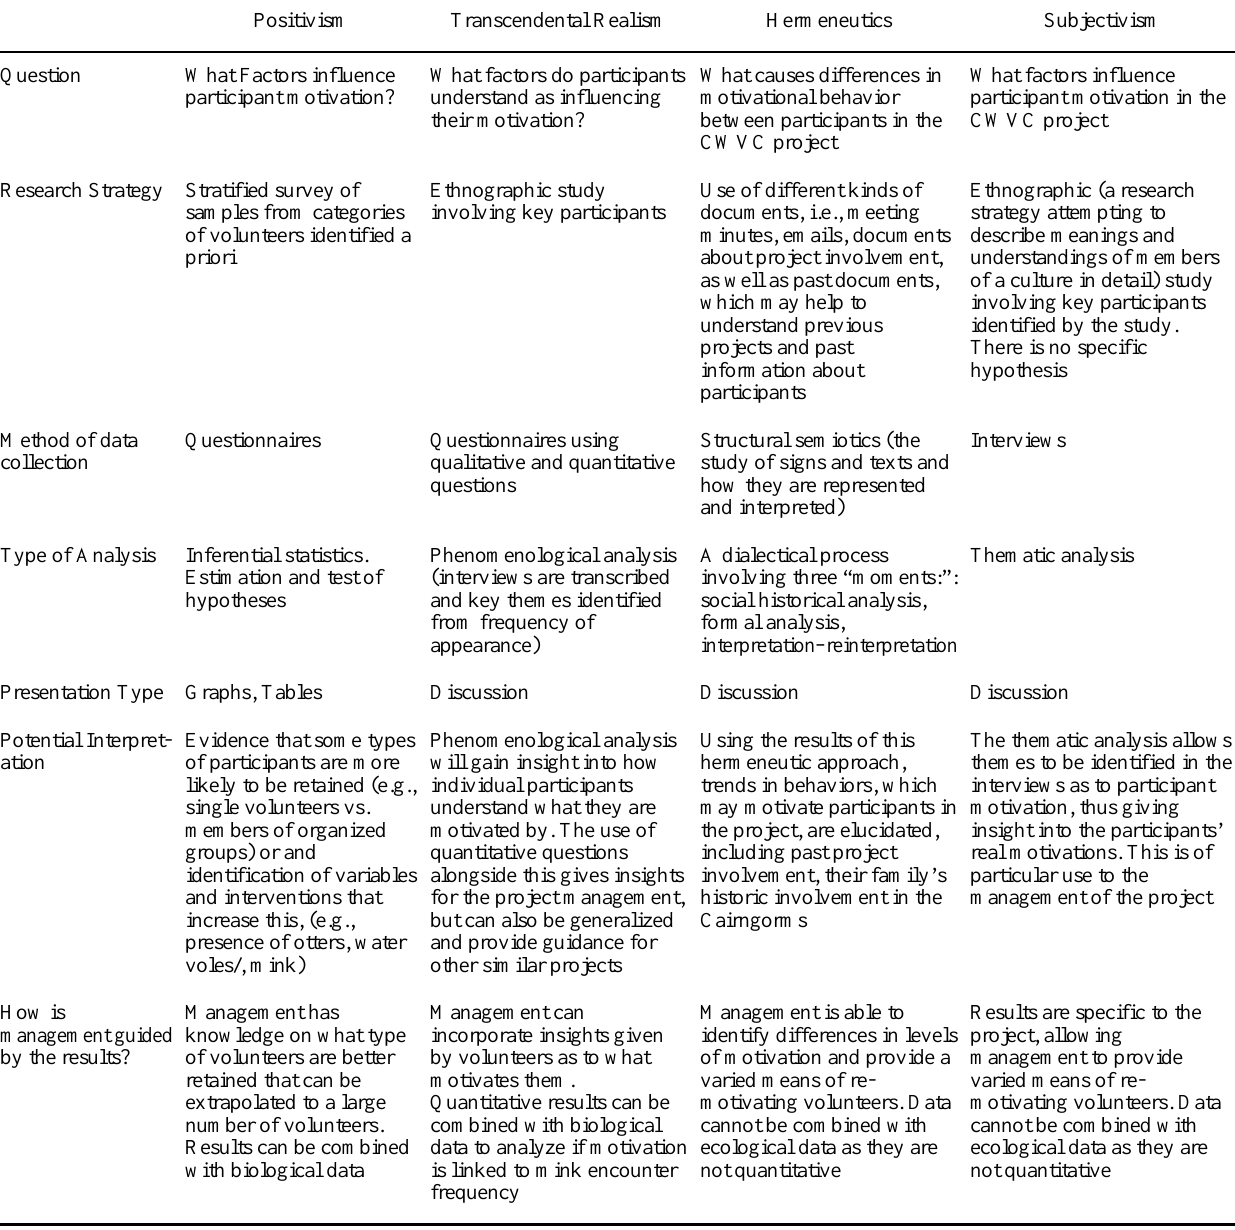
Table 3. The influence of various philosophical assumptions on research into volunteer motivation within the Cairngorms Water Vole Conservation Project. Based on Table 2’s